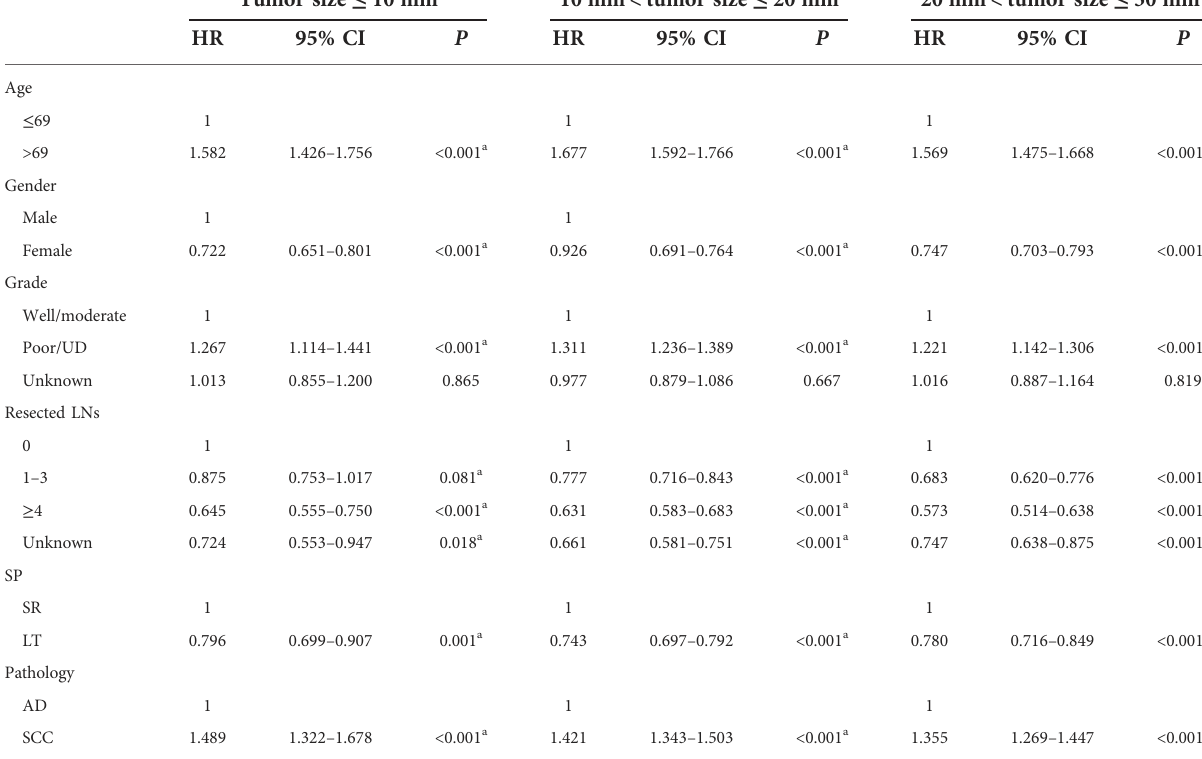
TABLE 4 Multivariate regression analyses for overall survival strati fi ed by tumor